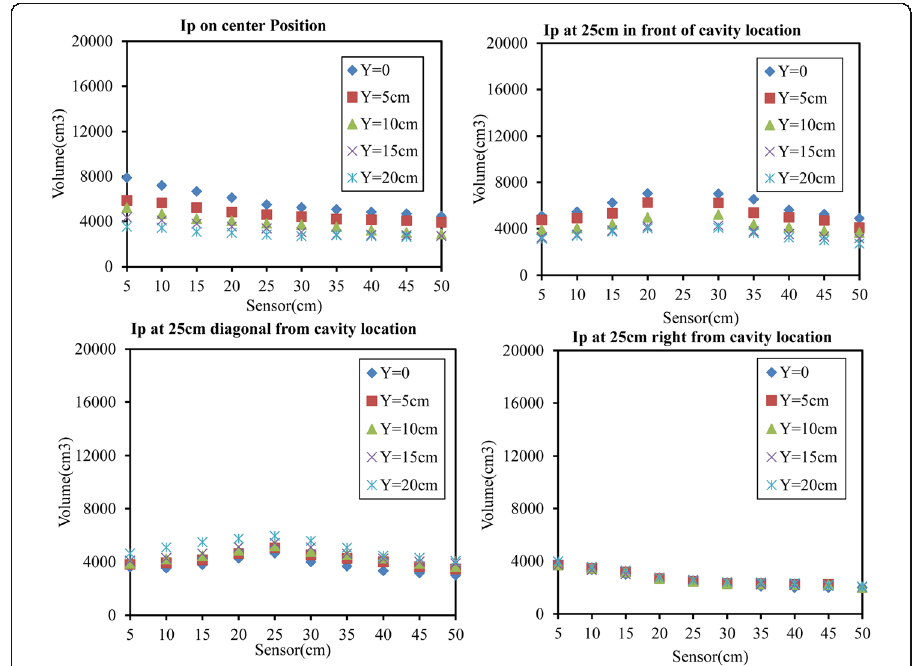
Fig. 23 Volume analysis for cavity size 5 × 5 × 0.75